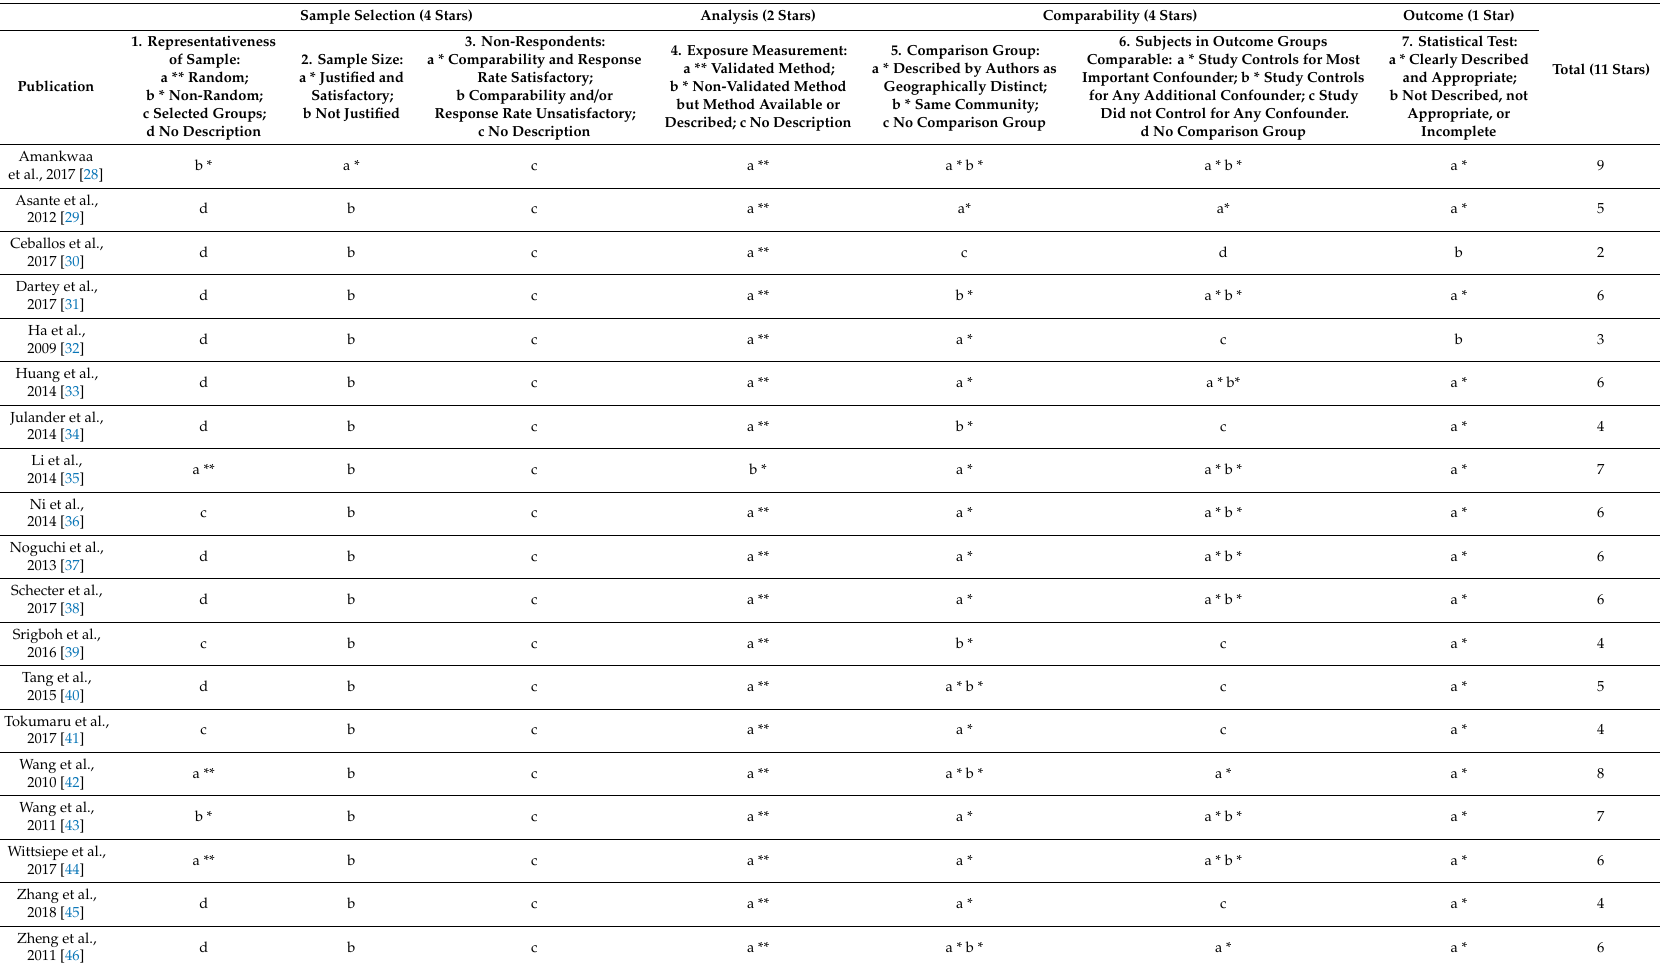
Table 3. Categories and results of the modified Newcastle–Ottawa Scale for cross-sectional